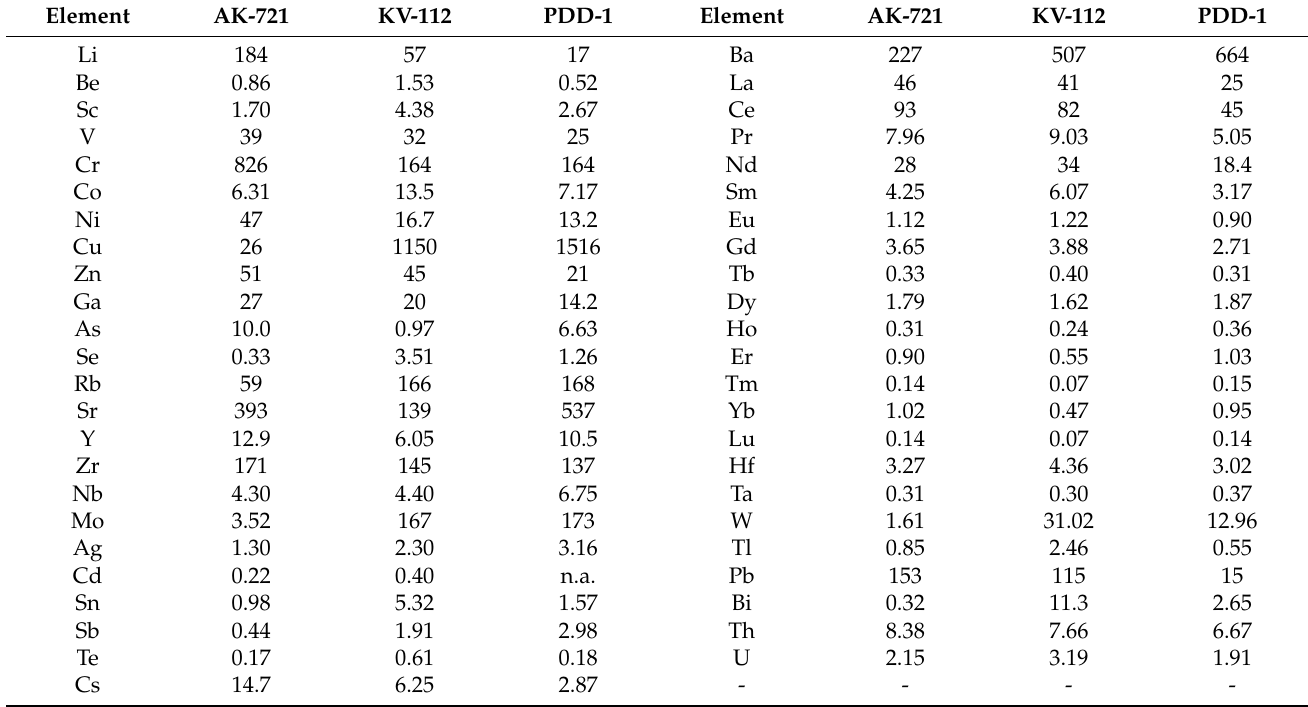
Figure 6. REE spectra for granite porphyry of the Pellapahk Cu-Mo and the Oleninskoe Au-Ag deposits, normalized by chondrite [35]. Table 2. ICP-MS data for granite porphyry (AK-721), and mineralized (KV-112, PDD-1) metasomatic rocks of the Pellapahk deposit, g/t.